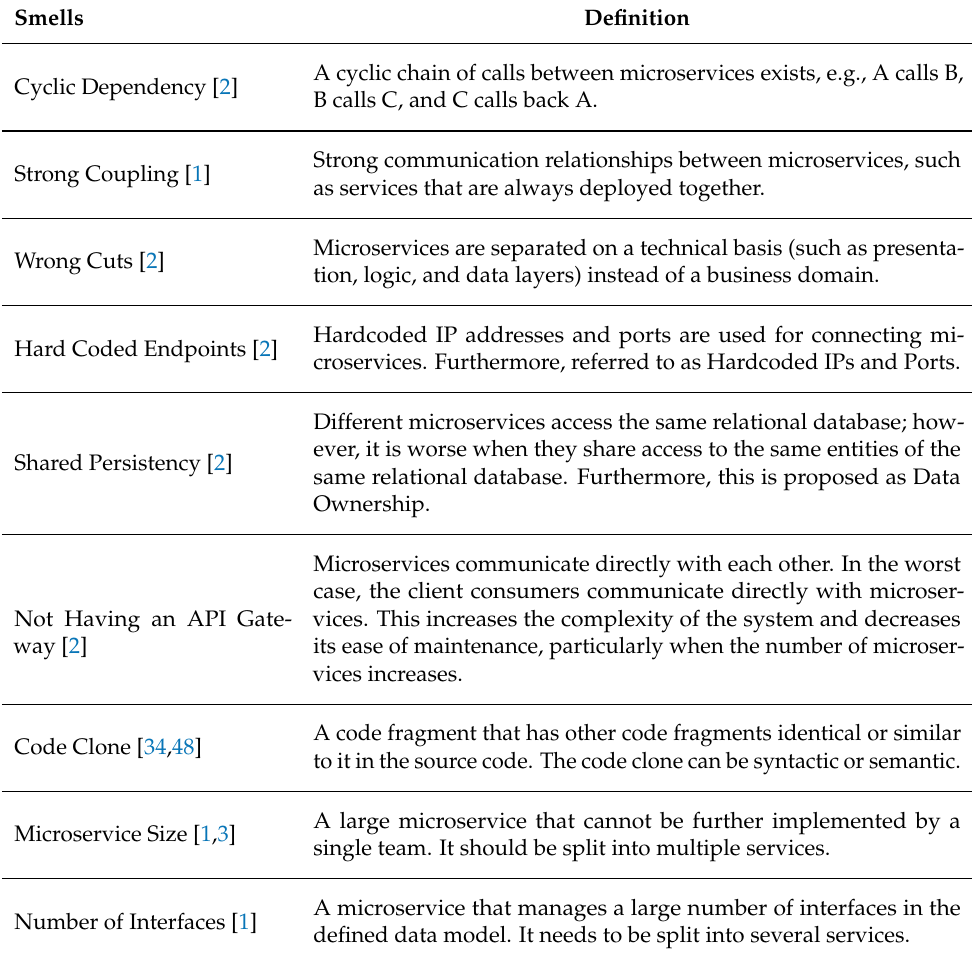
Table 3. Microservices smells